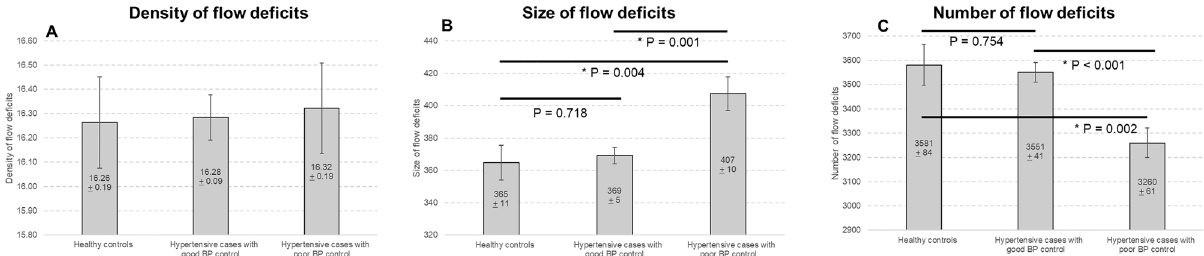
Figure 1. Distribution of ( A ) density, ( B ) size and ( C ) number of choriocapillaris flow deficits (CFD) in participants without hypertension (healthy controls), hypertensives with good blood pressure control and hypertensives with poor blood pressure control. Data and P values shown are after adjustment for age, gender, race and body mass index. Hypertensives with poor blood pressure control had the largest and fewest CFD than hypertensives with good blood pressure control and healthy